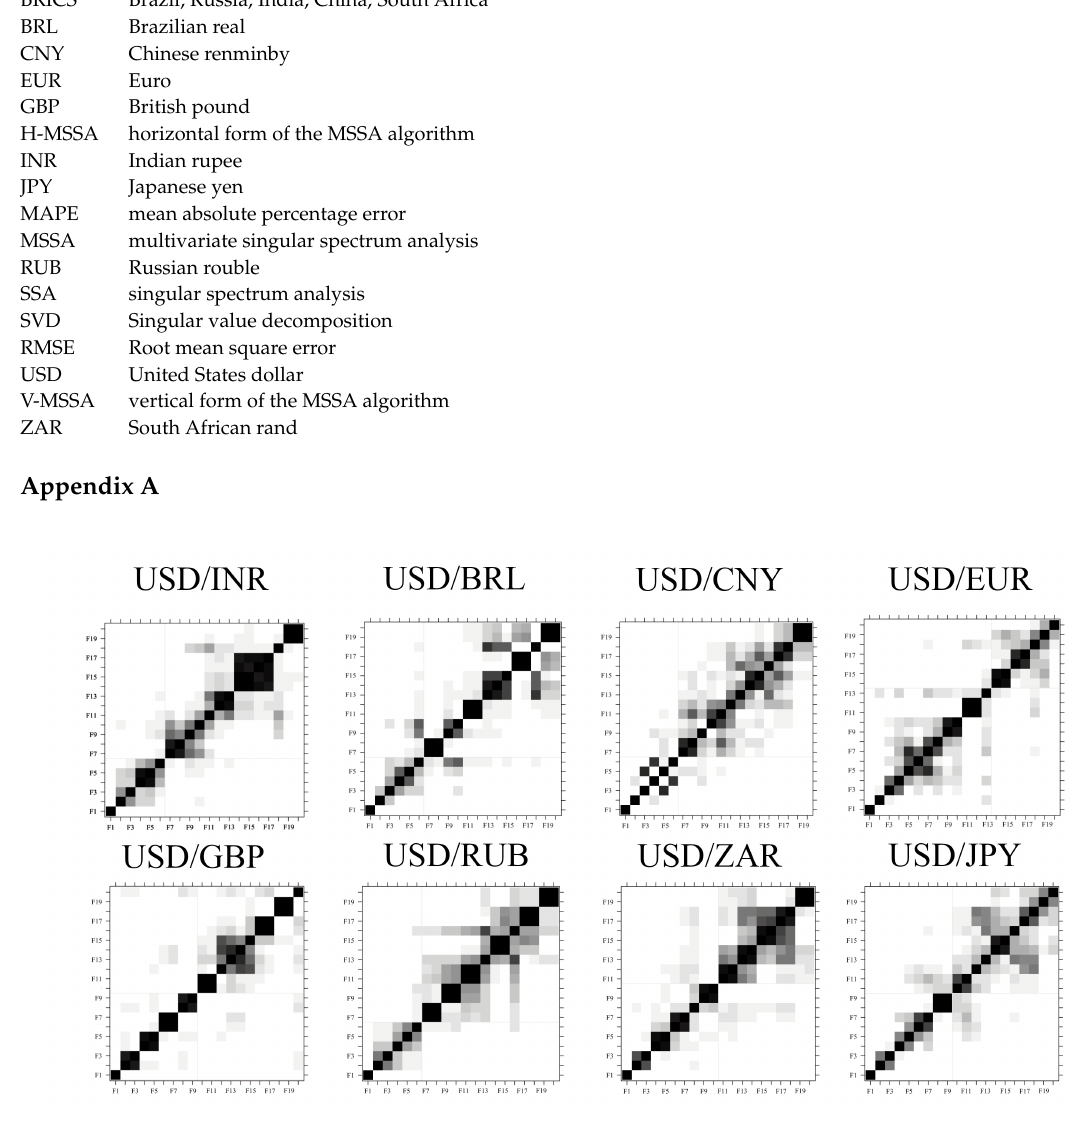
Figure A1. W-correlation matrices for each of the eight currency exchange rates, considering an window length L 1 = N /20. The vertical and horizontal lines in each w-correlations plot indicate the selected cut-point that maximize separability between signal and noise